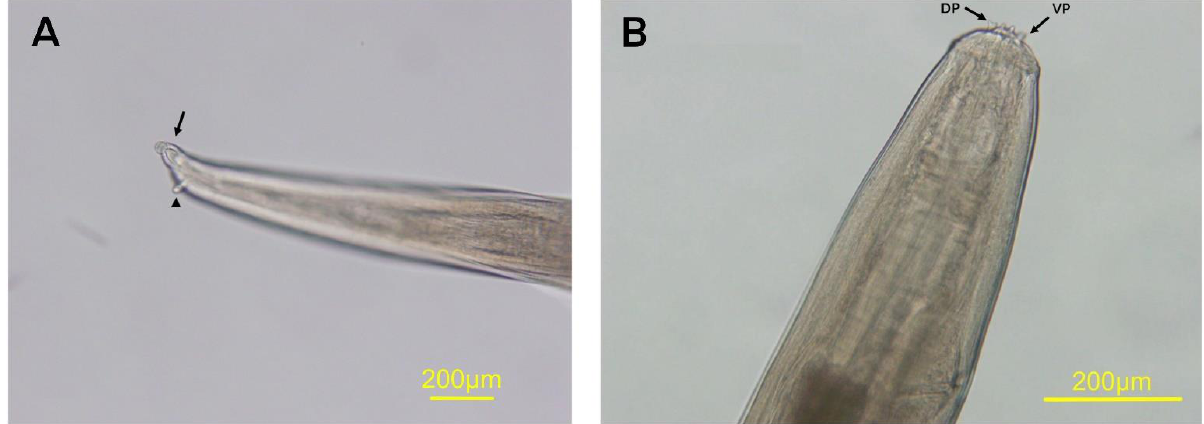
Figure 2. Posterior end of female adult of Setaria digitata has spherical terminal knob (arrow) and lateral appendages (arrowhead) ( A ). Anterior region of S. digitata shows the dorsal projection (DP) and ventral projections (VP) on peribuccal crown ( B ).